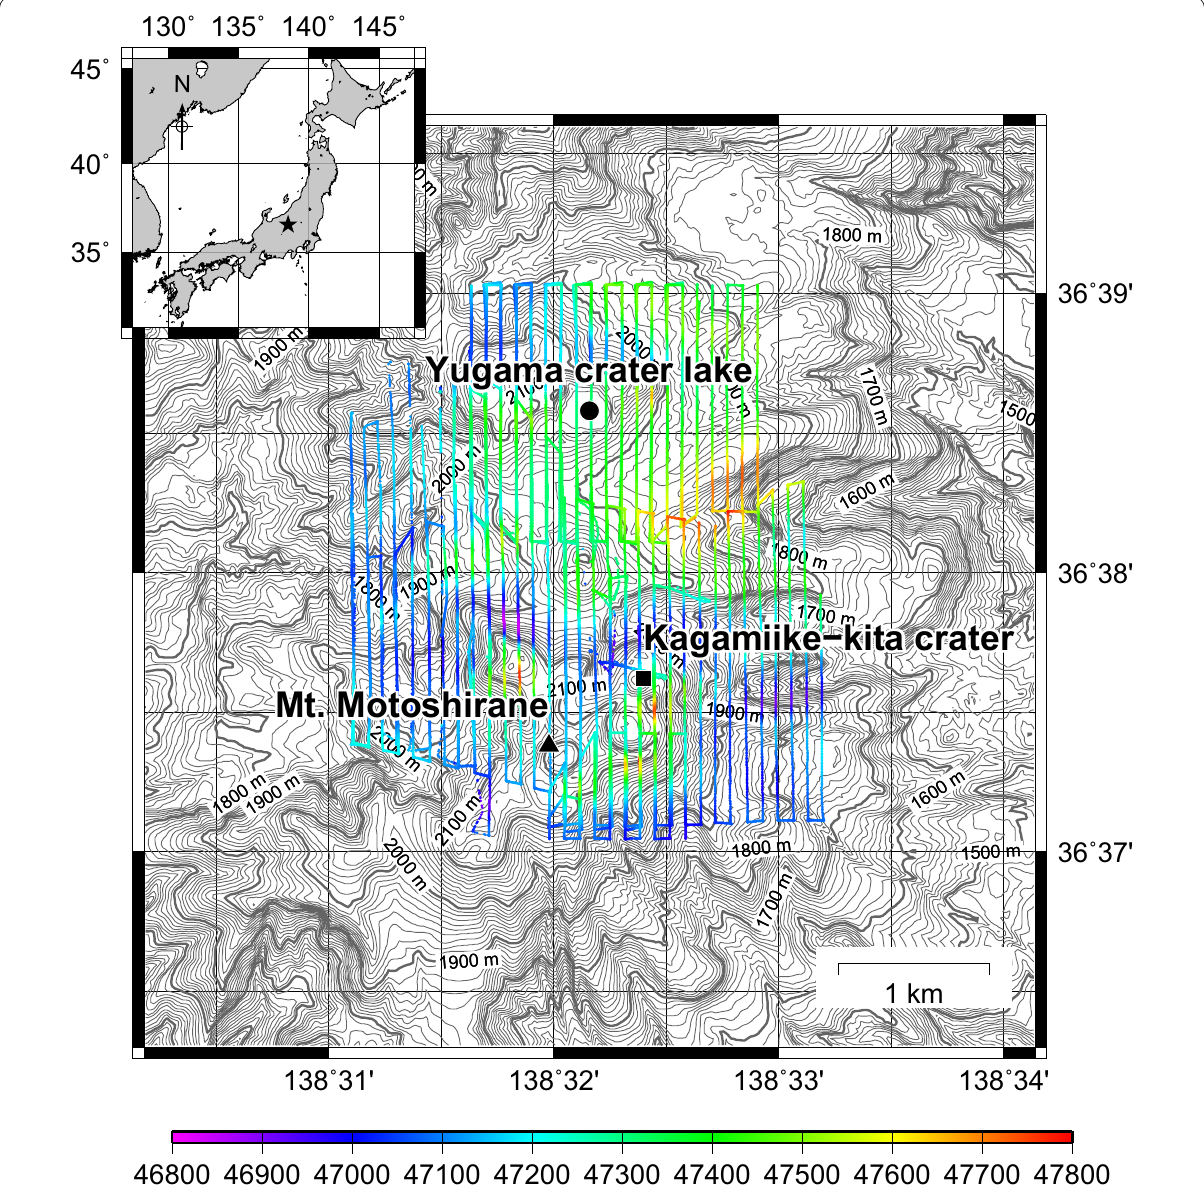
Fig. 1 Survey area map in Kusatsu-Shirane volcano: the flight course projected onto the plane map is color-contoured in the geomagnetic total intensity measured by the helicopter. The closed circle, square, and triangle indicate the locations of the crater lake Yugama of Mt. Shirane, Kagamiike-kita crater, and the main crater of Mt. Motoshirane, respectively. The star in the small map indicates the location of Kusatsu-Shirane volcano in